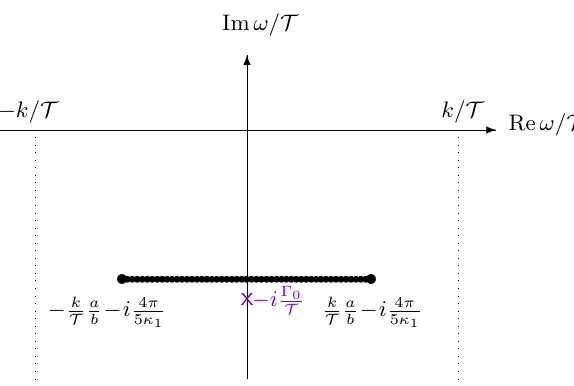
Figure 13 . Analytic structure of the response function in the kinetic sector. The branch cut arising from (5.15) is given by the thick black line. The pole corresponding to the pure damping mode (5.34), which lies on the second Riemann sheet, is indicated by the cross in